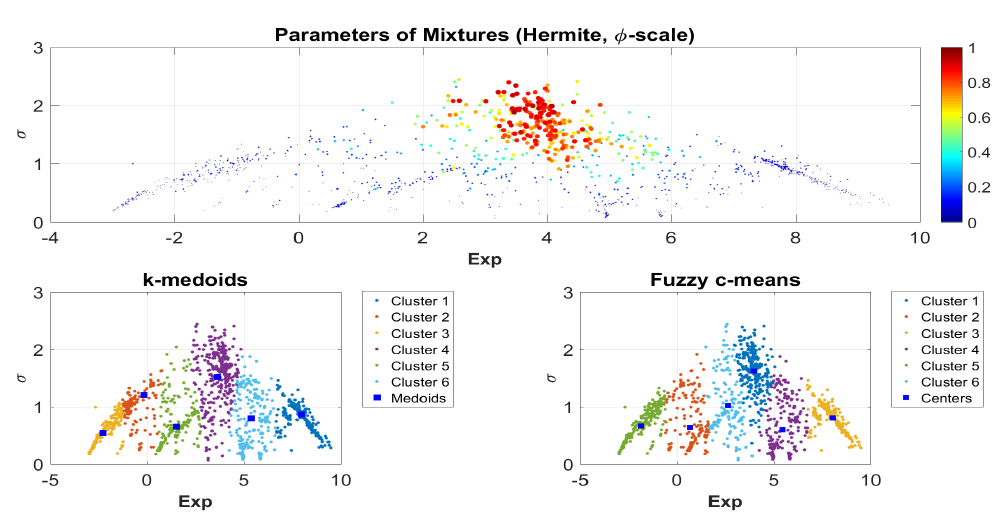
Figure A21. Clustering the mixture parameters (bootstrap, φ